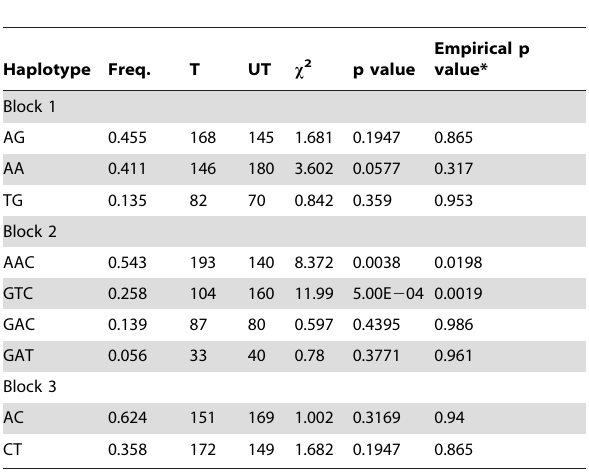
Table 2. Haplotype analysis of SNAP25 SNPs in ADHD nuclear